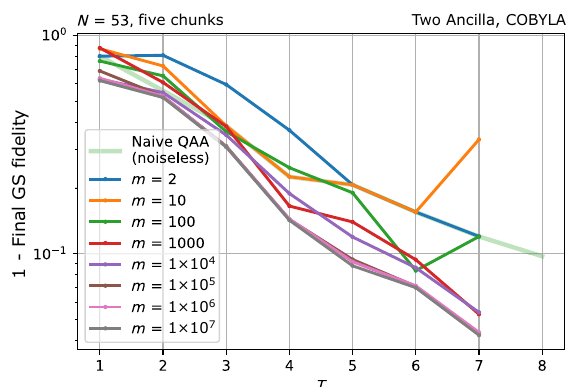
FIG. 22. The simulation of shot noise in the black-box algorithm for N = 53 and J = 1. Here, the two-ancilla method is used. The number of measurements taken for every ground- state overlap estimation is given by m . Note that no extra noise is applied during the circuit. COBYLA is used as the classical opti- mizer. For m > 10 3 , the results begin to converge and the shot noise is sufficiently small.